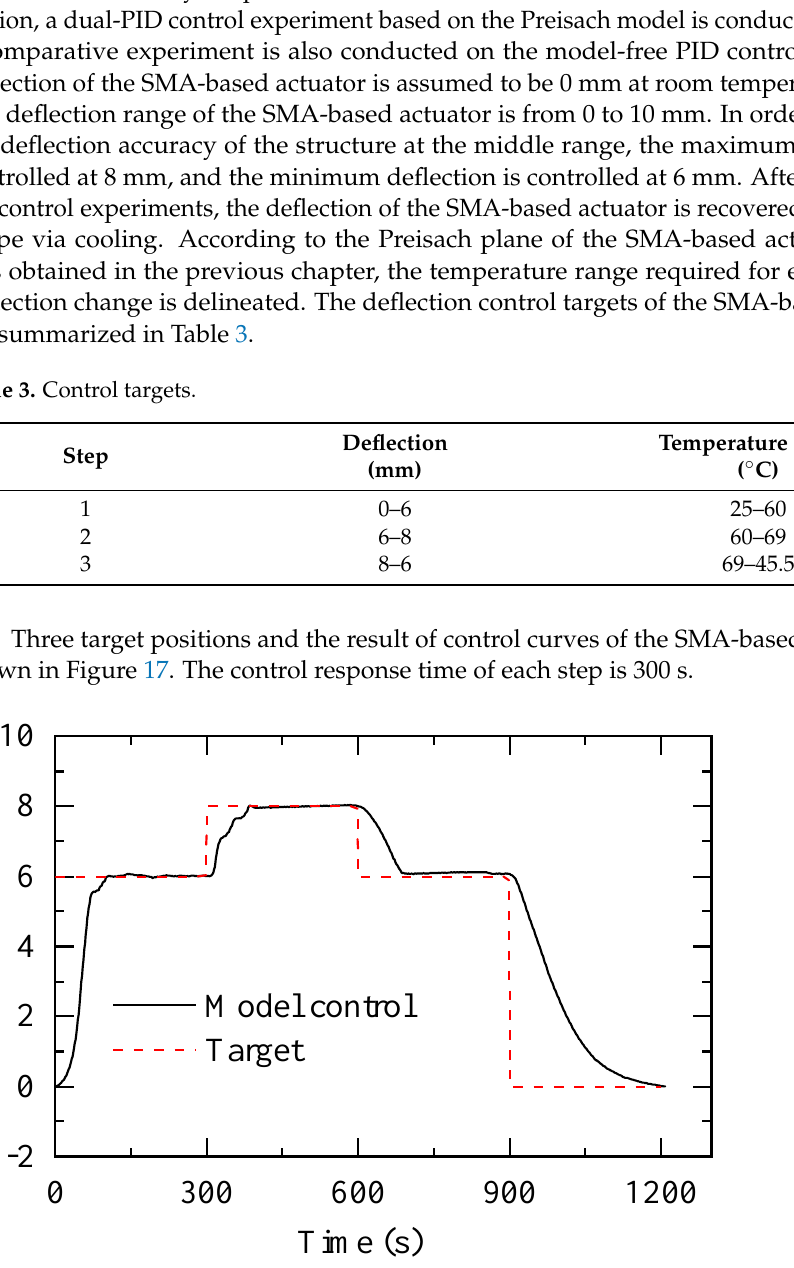
Figure 17. Model control result and the target values.